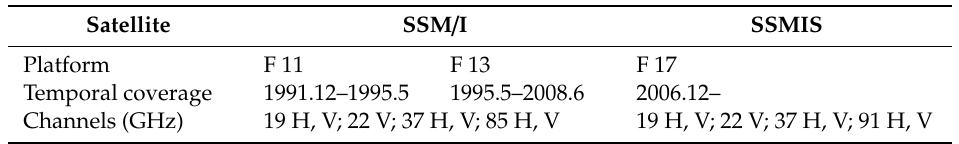
Table 1. Detail description for special sensor microwave imager (SSM / I) and special sensor microwave imager sounder (SSMIS) sensors. H and V denote the horizontal and vertical polarization,